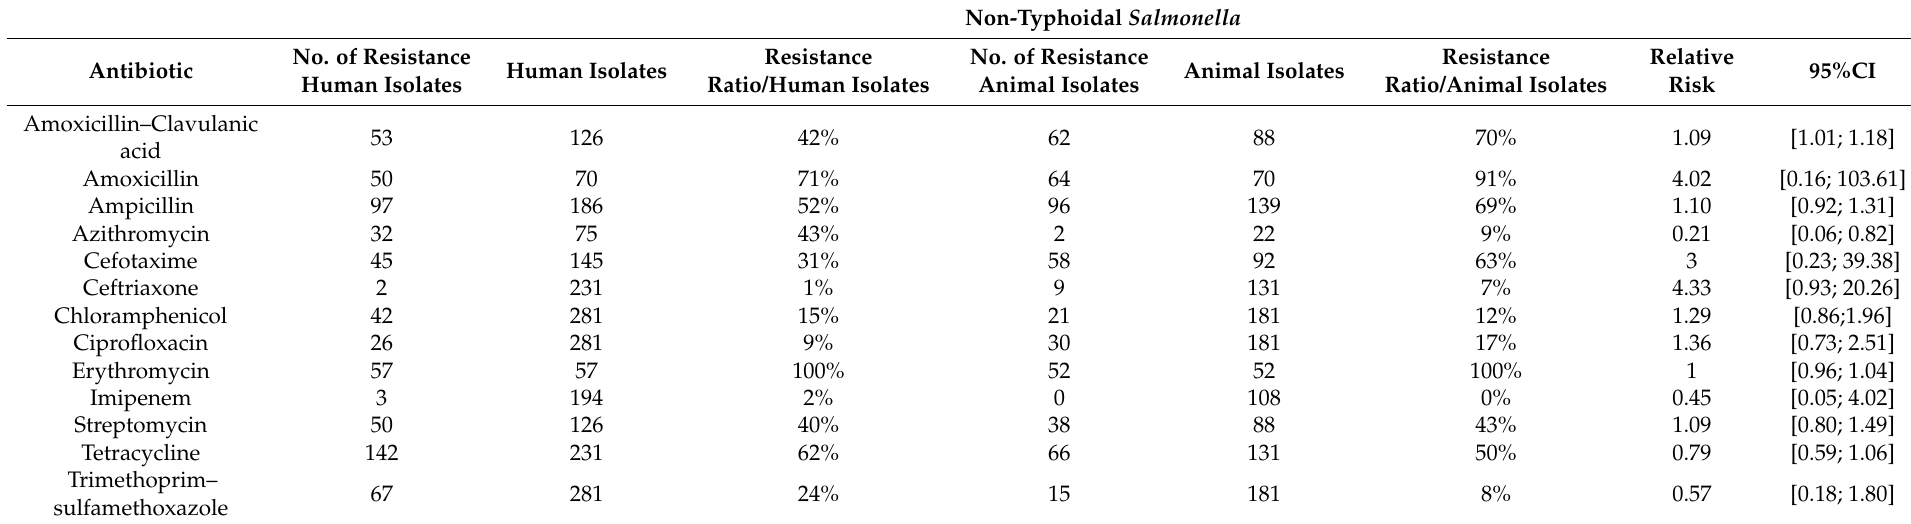
Table 3. Microbial resistance patterns detected by phenotypic screening among non-typhoidal Salmonella